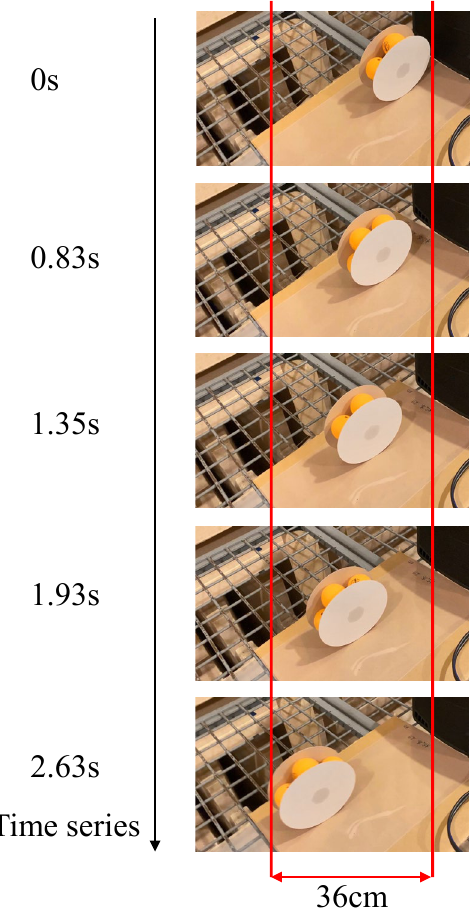
Figure 15. Movement of an improved actuator.